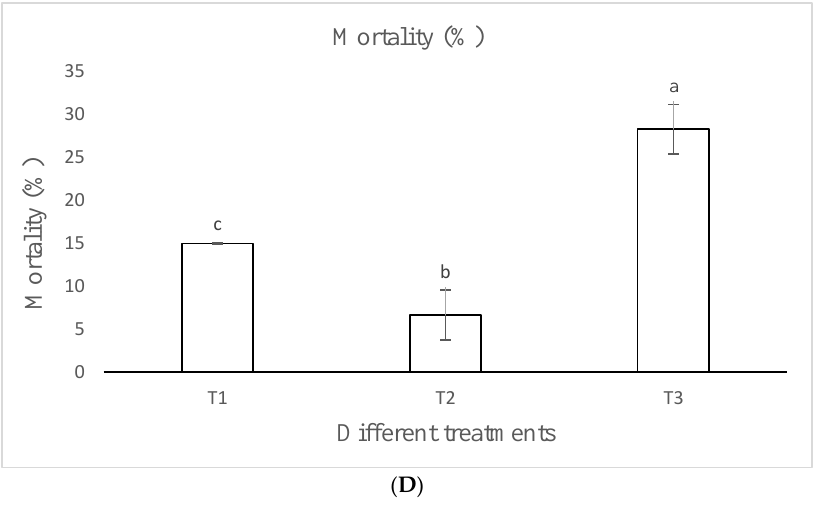
Figure 2. Individual biomass gain ( A ), total cocoon production ( B ), cocoons per worm ( C ), and mortality (%) ( D ) of Eisenia fetida after vermicomposting of macrophytes amended with cow manure and nutrient supplements. Values are the mean of three replicates, and bars indicate standard error (SD). The different letters between treatments denote statistical significance (ANOVA; Tukey’s HSD test at p < 0.05).